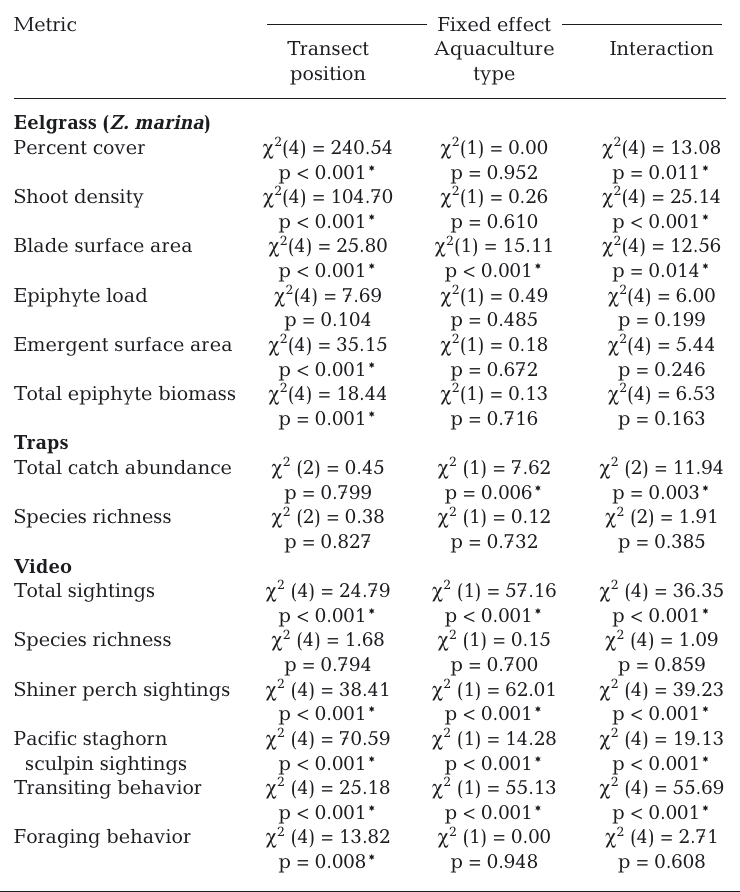
Table 1. Analysis of deviance tests following generalized linear mixed models on eelgrass Zostera marina presence and structure, minnow trap data,